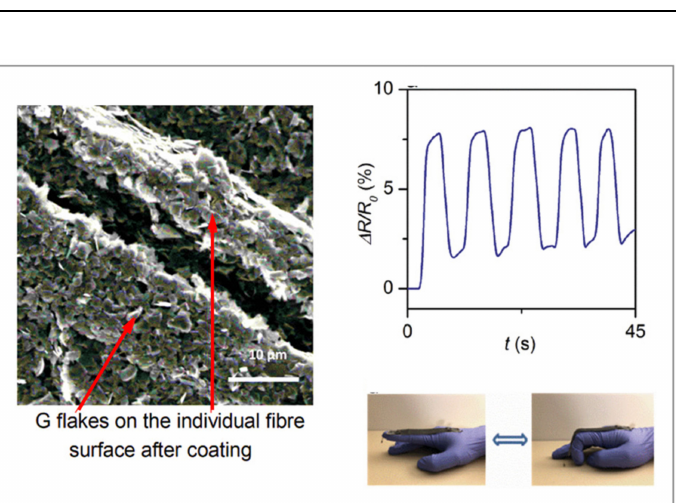
Figure 3. SEM image of G nanosheet coated textiles and corresponding strain sensing